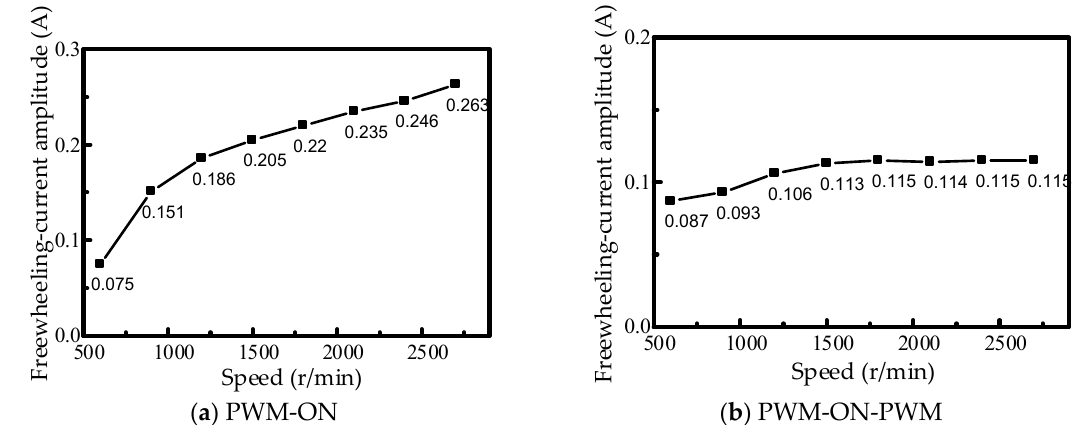
Figure 19. Relationship between freewheeling-current amplitude of non-conduction phase and speed.